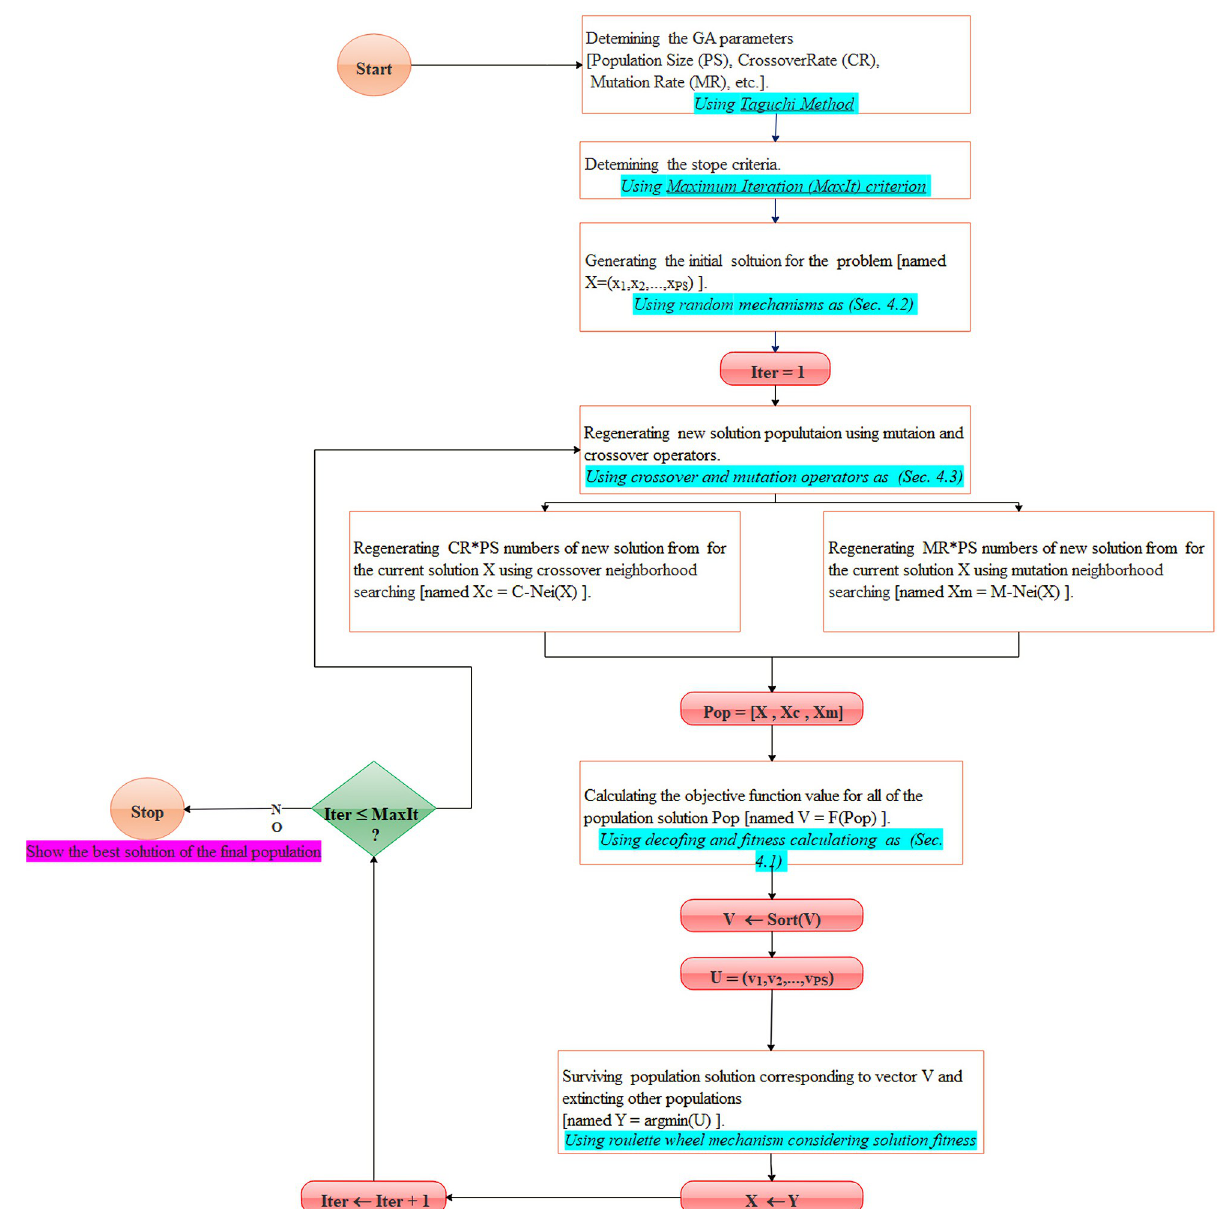
Fig 2. The flowchart of the proposed GA solver in solving the